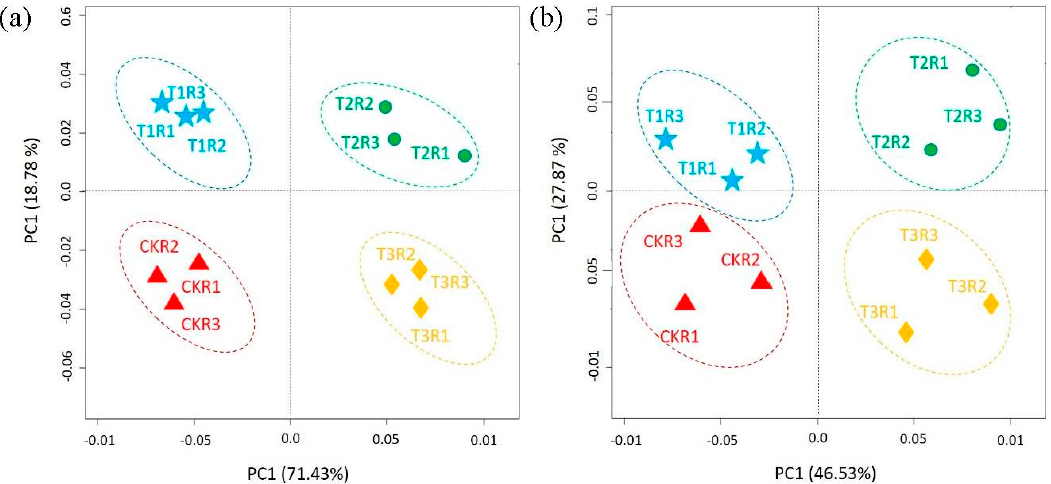
Figure 5. Principal component analysis of the bacteria ( a ) and fungi ( b ), revealing the community differences among all the soil samples.